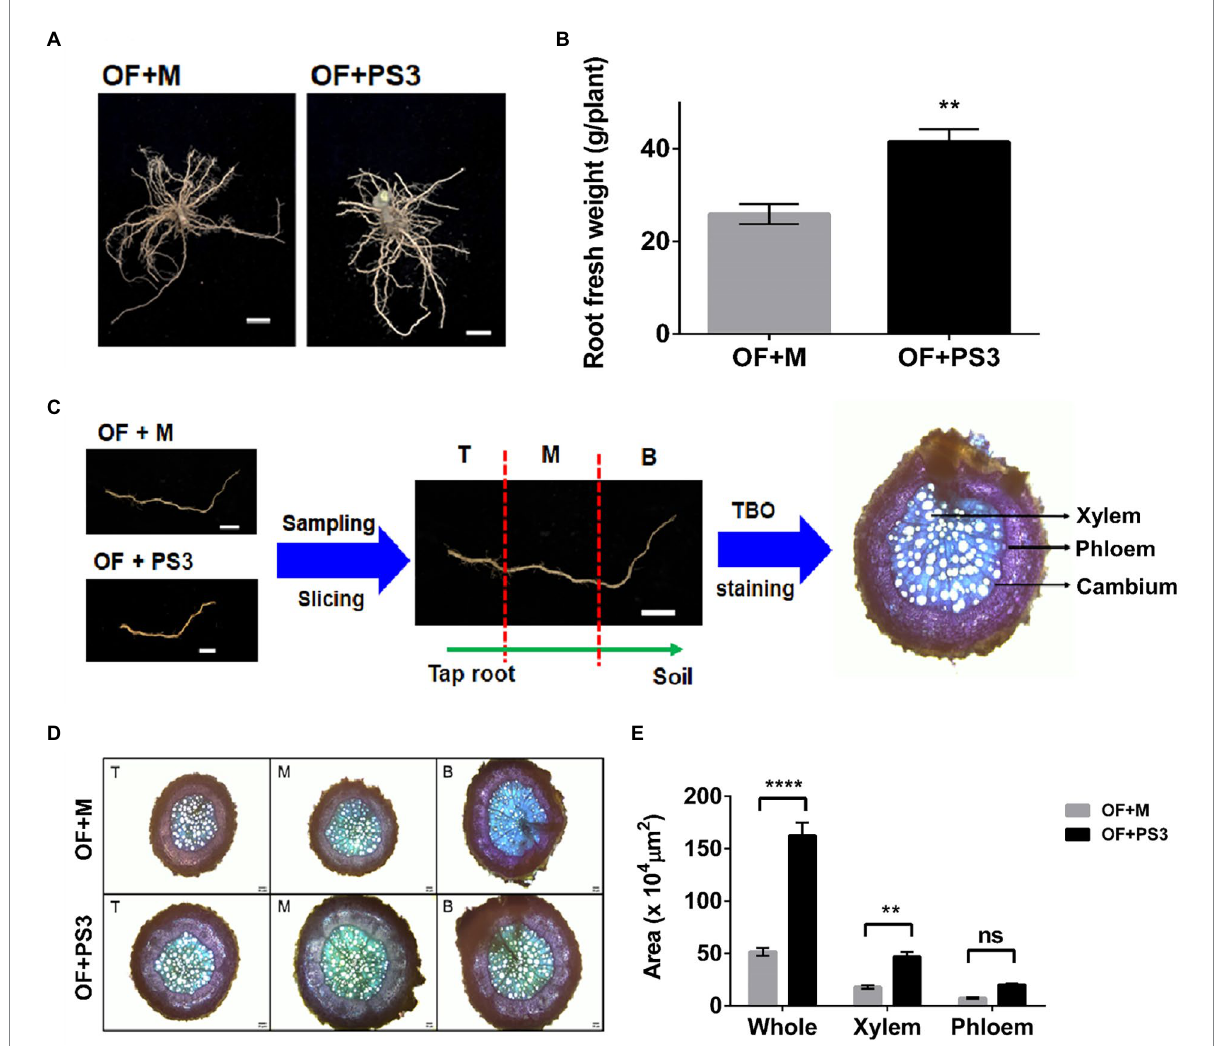
FIGURE 3 Comparison of the morphological root growth patterns between the control and Rhodopseudomonas palustris PS3 inoculation groups. (A) Root phenotype. (B) Root fresh weight. (C) Sampling procedures for light microscopic observation. Sampling and sectioning methods are based on distance from taproot, where T is close to tap root, M distance is midway between taproot and soil, and B is far away from taproot. (D) Cross-sections of grafted tomato roots (T, M, and B) stained with Toluidine blue (TBO). (E) Average total root area, xylem area, and phloem area. The statistical test was based on Welch’s t -test.(ns, p ≥ 0.05; ** p < 0.01, **** p < 0.001). Data are expressed as the mean ±